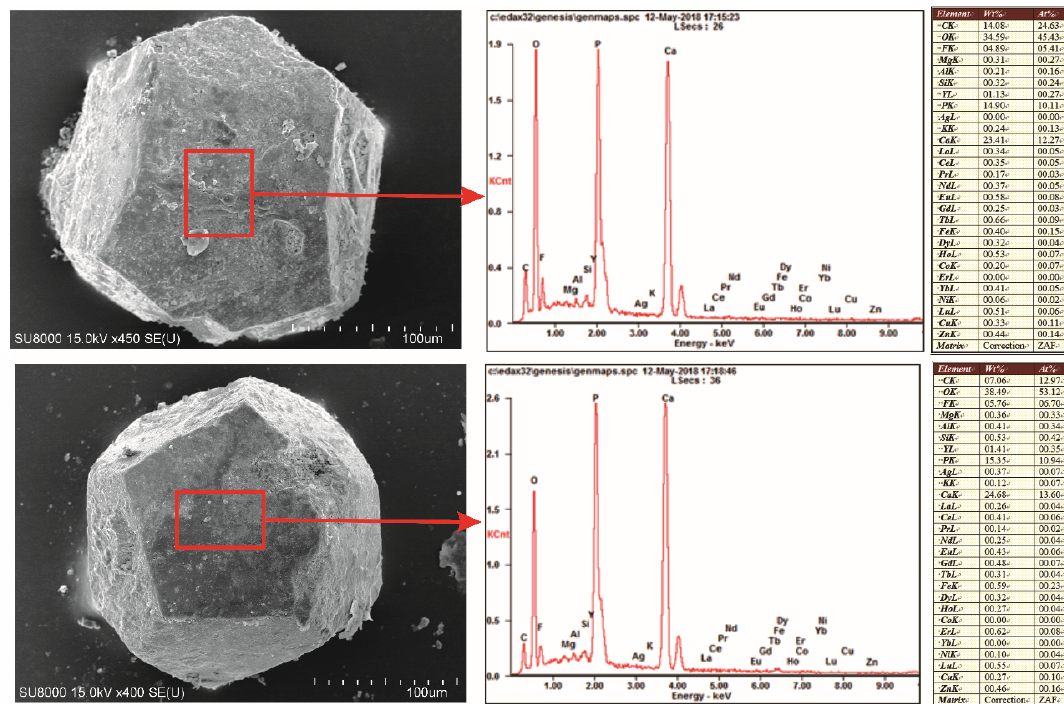
Figure 1. The microstructure and composition of apatite by using SEM ‐ EDS analyses.